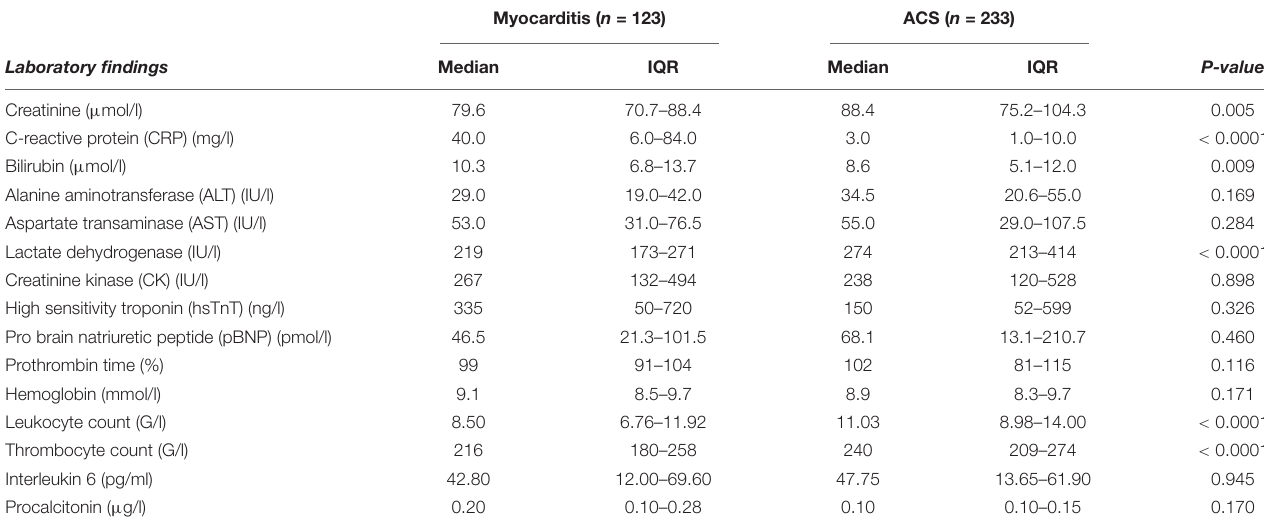
TABLE 2 | Laboratory findings in both